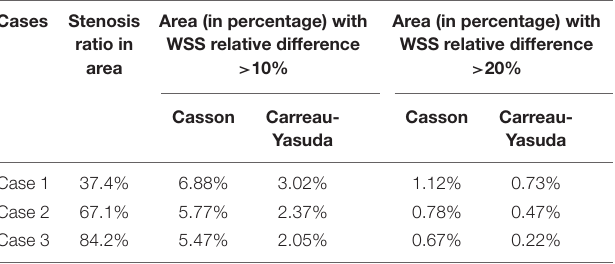
TABLE 1 | The areas (in percentage) in each case with the relative difference between Newtonian and non-Newtonian models larger than 10 and 20%. Cases Stenosis ratio in